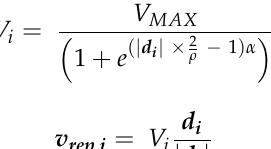
the feedback joint degrees of freedom provided by the UR controller. The distances between the human joints and the points on the UR3 robot are then evaluated using the knnsearch algorithm [38]. This algorithm, given as inputs of two sets of points X and Y (in this case the points are respectively the position vectors of the joints of the optimized skeleton and of the points of the clusters) finds the nearest neighbor in X for each query point in Y and gives as outputs the distances. Given the human-robot distances d i , the repulsive